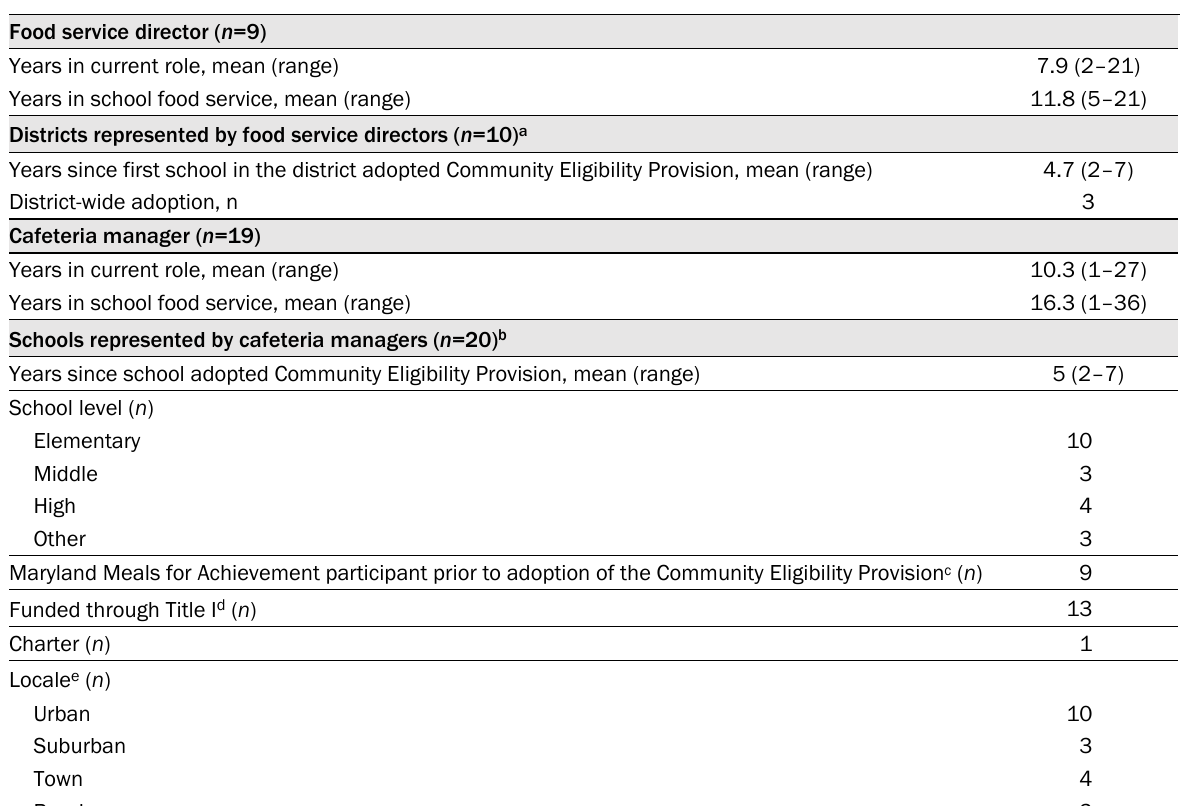
Table 2. Characteristics of Participating Food Service Directors and Cafeteria Managers ( n =28) and the Districts and Schools They